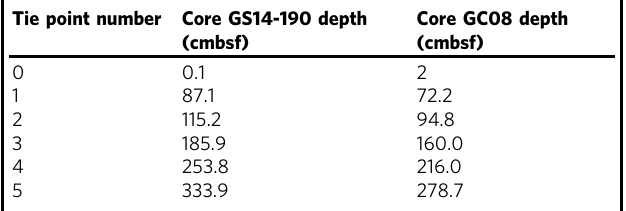
Table 2 Different depths of correlation tie points 1 – 5 in cores 33-GC08 and GS14-190-01PC based on XRF-Ca records